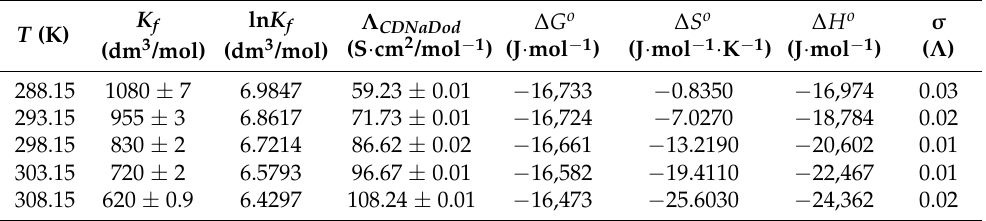
Table 2. The value of formation constant K f (dm 3 /mol), theoretical conductivity Λ CDNaDod (S · cm 2 /mol − 1 ) and the values of thermodynamic functions ∆ G o , ∆ H o and ∆ S o for α -cyclodextrin with the salt of trans -cinnamic acid.